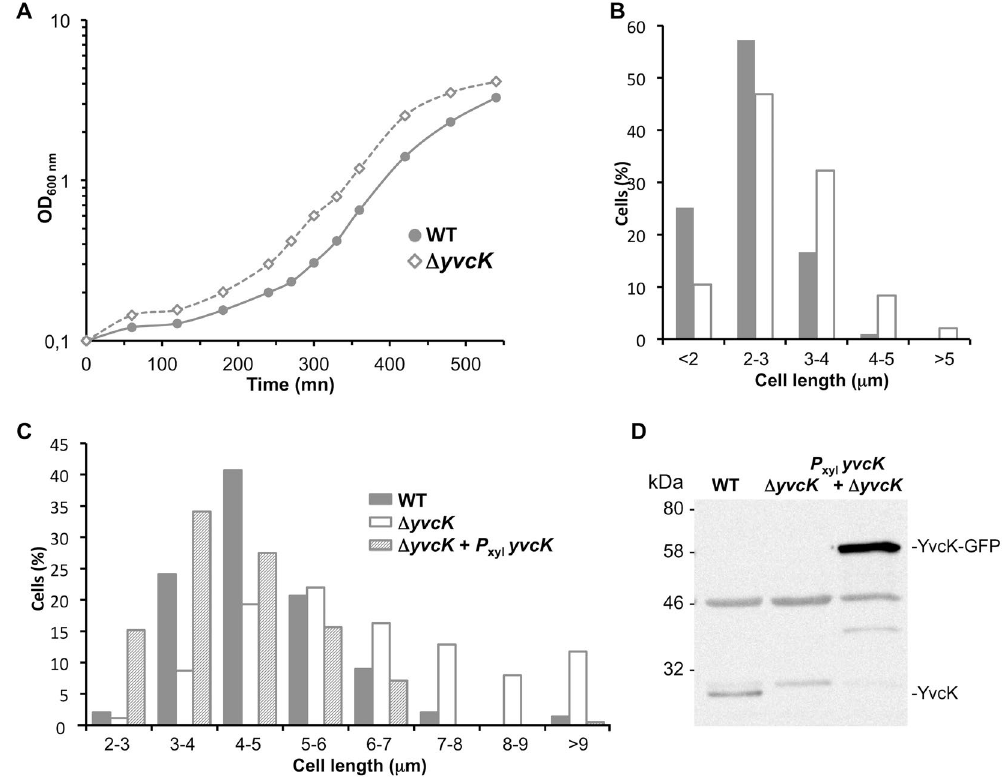
Figure 2. YvcK regulates cell length. ( A ) Growth curve of WT strain (168) and Δ yvcK mutant strain (SG471) on minimal medium with sorbitol as sole carbon source. ( B ) Histogram of cell lengths for 168 and SG471 strains collected at OD 600 = 0.4: WT (n = 306), Δ yvcK strain (n = 335). ( C ) Histogram of cell lengths for WT strain (168), Δ yvcK strain (SG471) and Δ yvcK strain with P xyl yvcK at amyE locus (SG517). These three strains were grown in LB medium in the presence of xylose and collected at OD 600 = 0.4: WT (n = 319), Δ yvcK strain (n = 256), Δ yvcK, P xyl yvcK strain (n = 301). ( D ) Analysis of YvcK production from crude extracts of WT strain (168), Δ yvcK strain (SG471) and Δ yvcK strain with P xyl yvcK at amyE locus (SG517) by Western blotting. Bacteria were collected at OD 600 = 0.4, lyzed and 10 μ l of cell extracts were run on a 12.5% SDS-PAGE and transferred to nitrocellulose membrane by electroblotting. The blot membrane was exposed for each time set in interval time and accumulates images. Full-length blot is presented in Supplementary